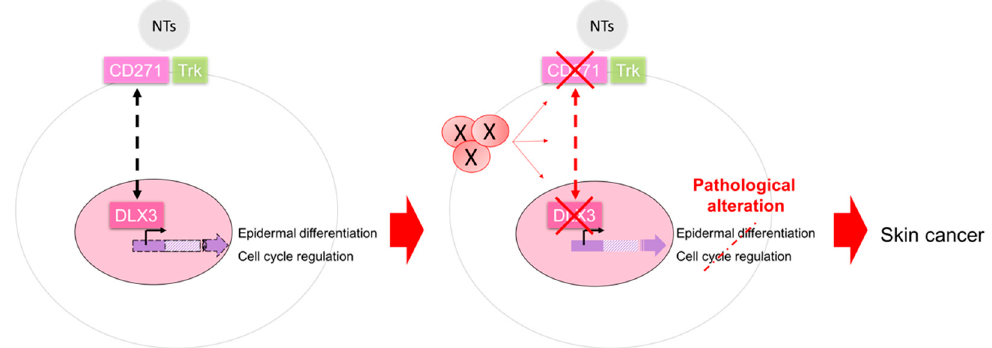
Figure 4. Alteration of CD271-DLX3 connection in keratinocytes. A CD271 and DLX3 feedback loop is required for the maintenance of the epidermal homeostasis through a fine regulation of the epidermal differentiation and cell cycle processes. The absence of their mutual signals, also due to other factors (X), is involved in pathological alterations that are a prelude to cancer development.